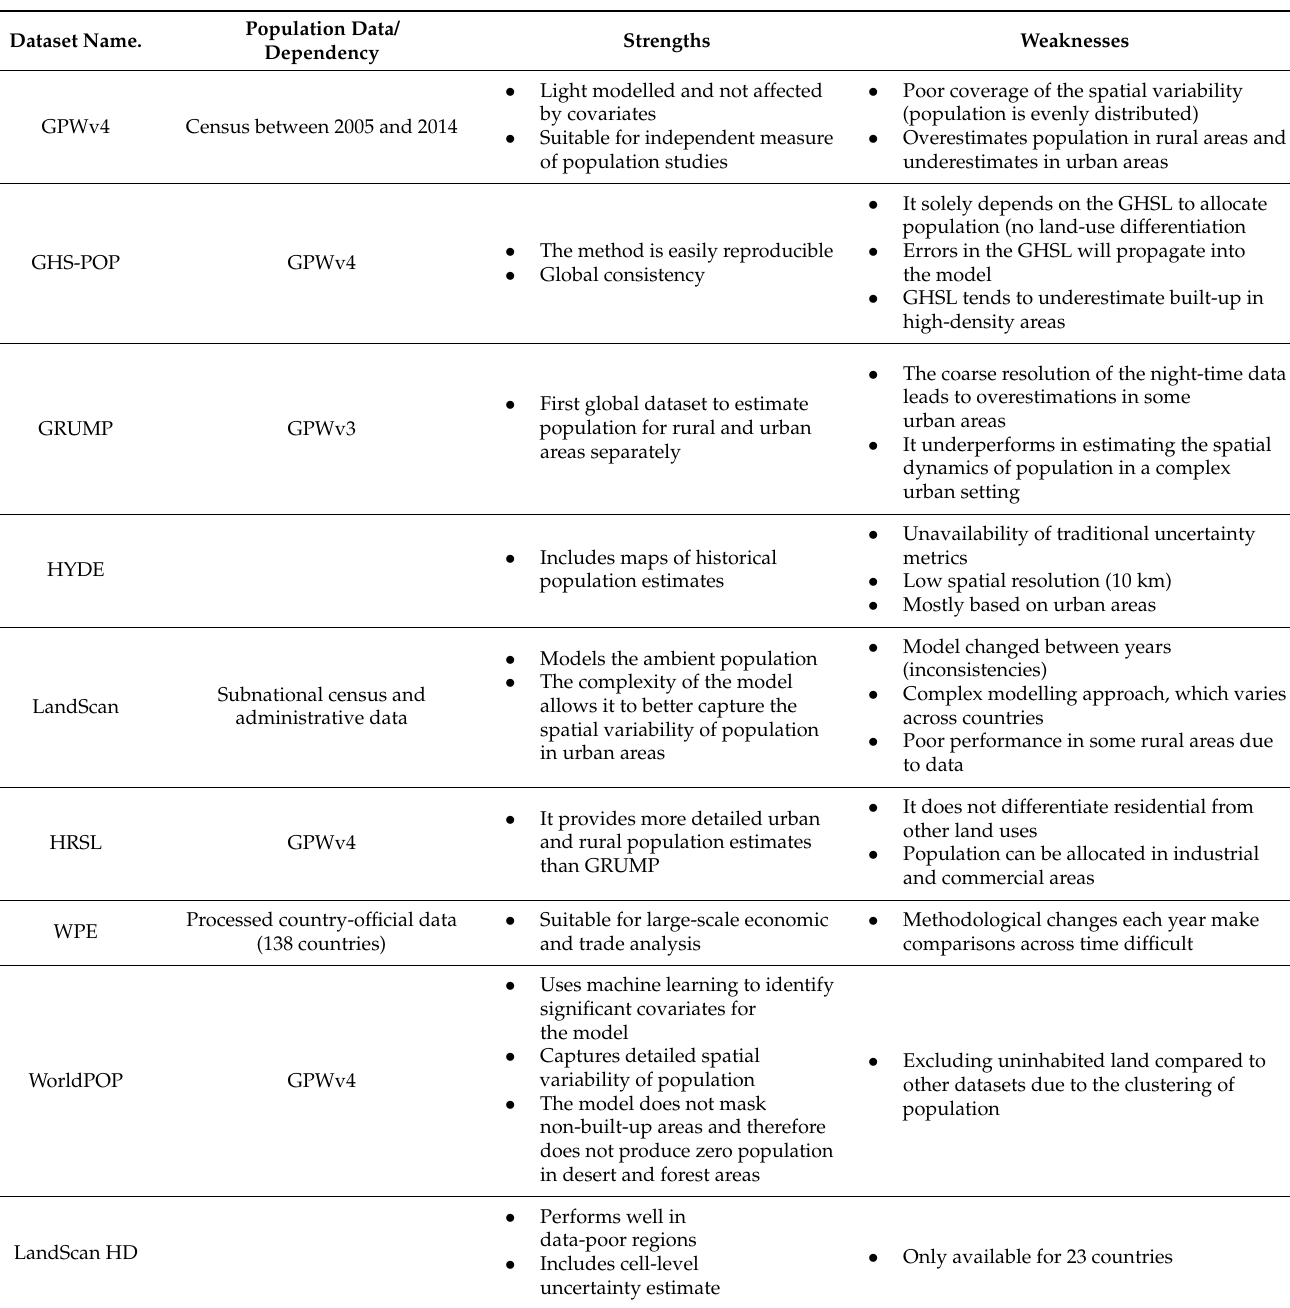
Table 1. Strengths and weaknesses of population models reported in the literature [8,23,33,34,36–38] (GPWv4 is based on 2010 round of census and includes over 12,500,000 units and GPWV3 was based on 2000 round of census and includes over 375,000 input